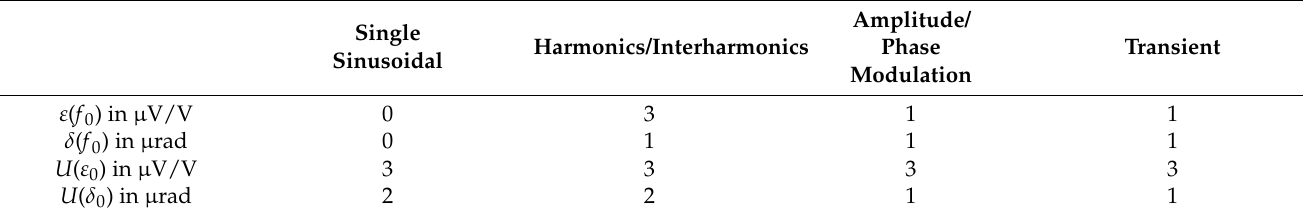
Table 4. The errors and uncertainties of the two-channel measuring system at 50 Hz with input voltage ranging from 0.1 V to 3 V under various PQ phenomena.